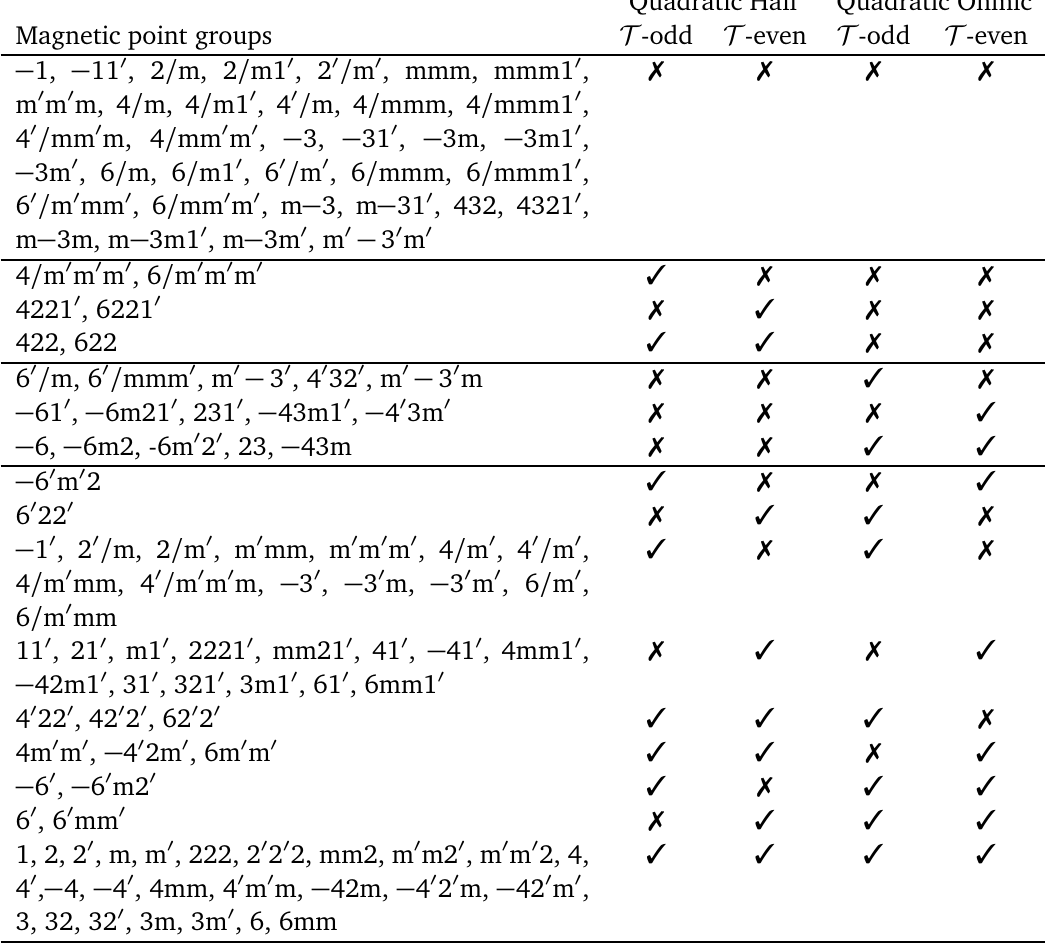
Table 2: Magnetic point groups classified by the existence or absence of the four symmetry types of quadratic conductivities in a vanishing external magnetic